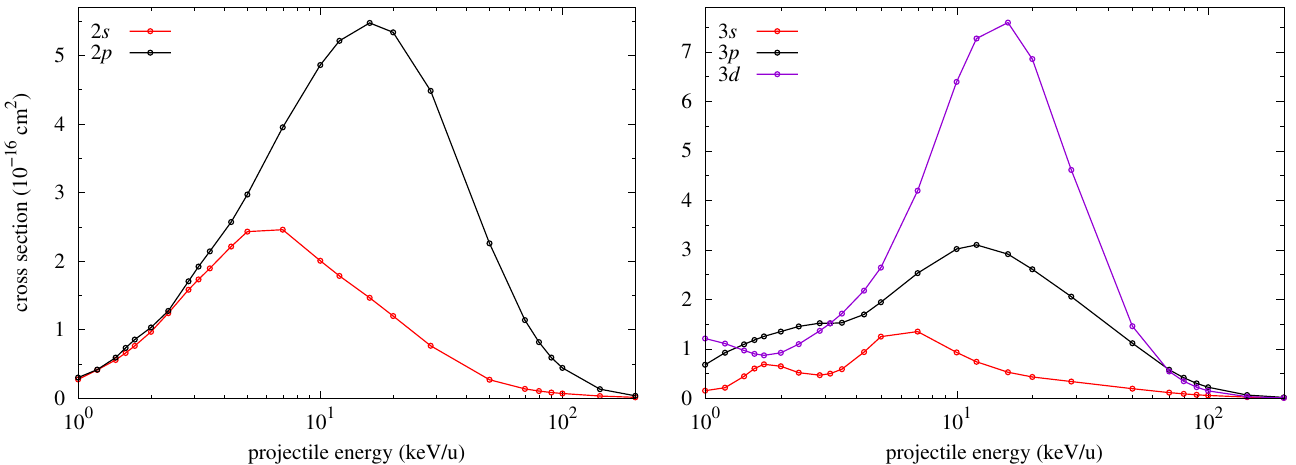
Figure 3. The 2 l and 3 l electron-capture cross sections for Li 3 + − H(1s) collisions over the projectile energy range from 1 to 300